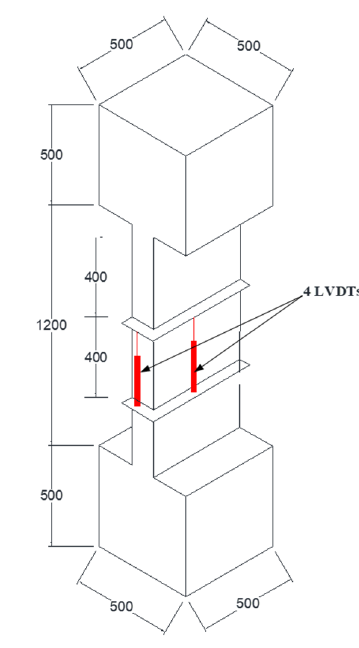
Figure 7. Test setup and instrumentation layout.